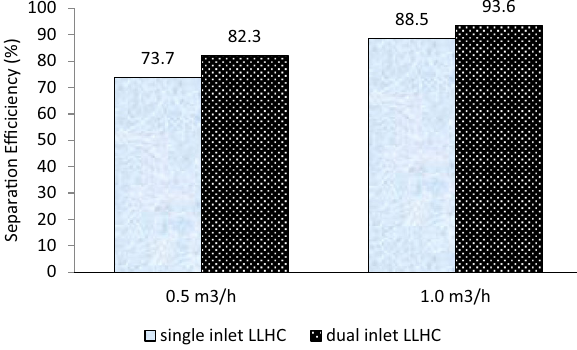
Fig. 11 Separation efficiency of the LLHCs at 0.5 m 3 /h and 1.0 m 3